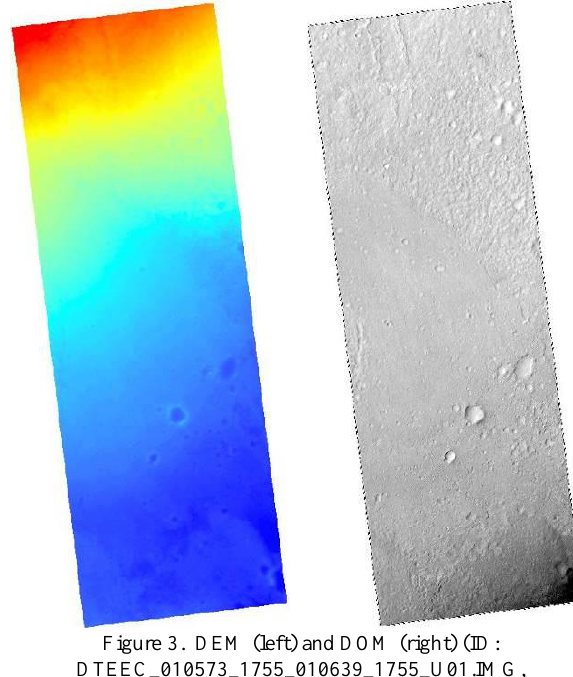
Figure 3. DEM (left) and DOM (right) (ID: DTEEC_010573_1755_010639_1755_U01.IMG, PSP_010573_1755_RED_A_01_ORTHO.JP2) generated from of HiRISE stereo images